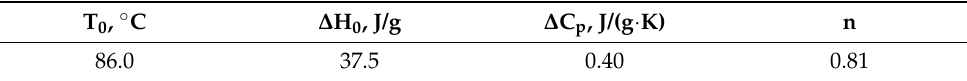
Figure 7. Temperature dependencies of specific heat capacities of metal-depleted and Sr 2+ /Ca 2+ - bound states of rWT α -PA, derived from DSC data according to [47]. Protein concentration is 1.2–1.8 mg/mL. Buffer conditions: 10 mM H 3 BO 3 -KOH pH 9.0, 1 mM SrCl 2 /CaCl 2 or without additions. Heating rate is 0.86 K/min. The data for the Sr 2+ -loaded form were analyzed according to the cooperative two-stat e model (4). The theoretical curve is shown in light grey. The dotted curve corresponds to the specific heat capacity of the fully unfolded α -PA, calculated according to [32]. Table 3. Thermodynamic parameters of thermal denaturation of Sr 2+ -loaded α -PA estimated from the DSC data shown in Figure 6 according to the cooperative two-state model (4): mid-transition temperature ( T 0 ), enthalpy of protein denaturation at temperature T 0 ( ∆ H 0 ), heat capacity change accompanying the transition ( ∆ C p ) and number of molecules involved into transition ( n ).